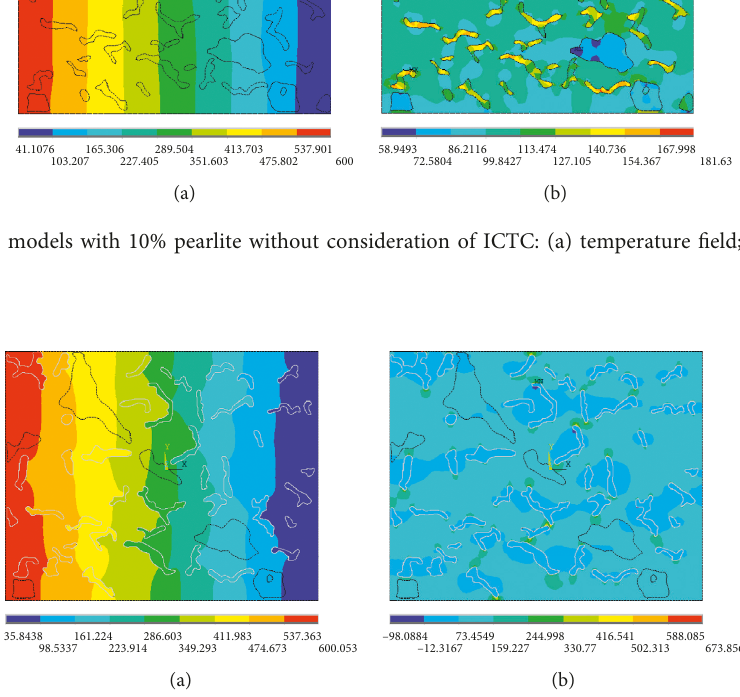
Figure 7: FE models with 10% pearlite with consideration of ICTC: (a) temperature field; (b) heat flux.